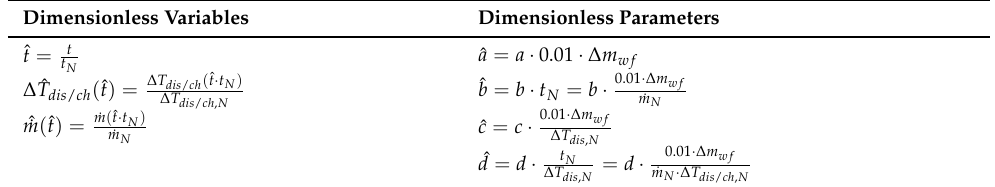
Table 2. Dimensionless variables and parameters of differential Equation